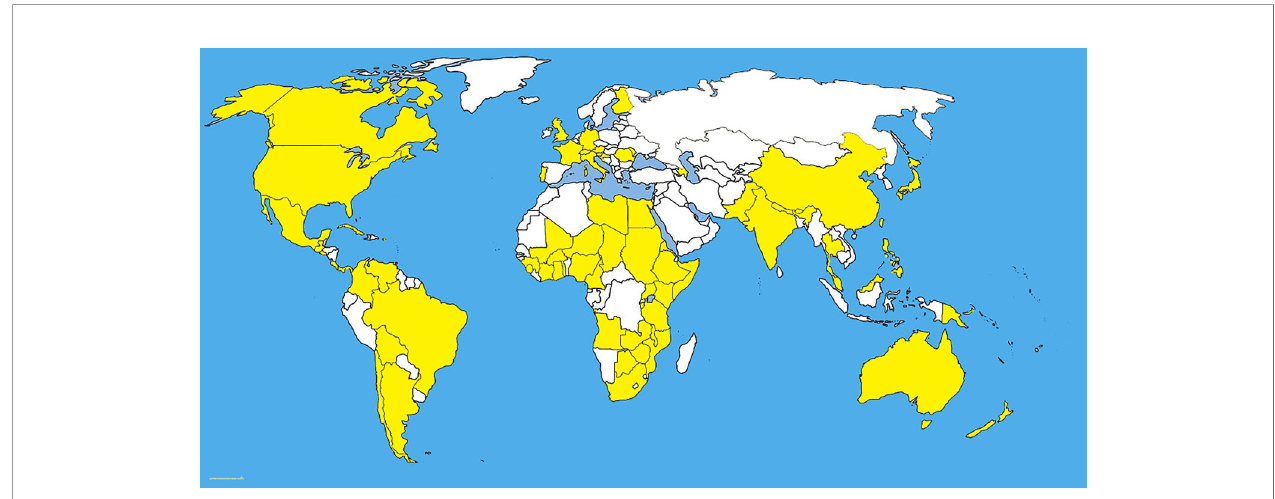
FIGURE 6 | The distribution map of Colletotrichum graminicola sensu lato. The areas where infection have been reported are indicated in yellow (www.cabi.org/isc. Accessed on